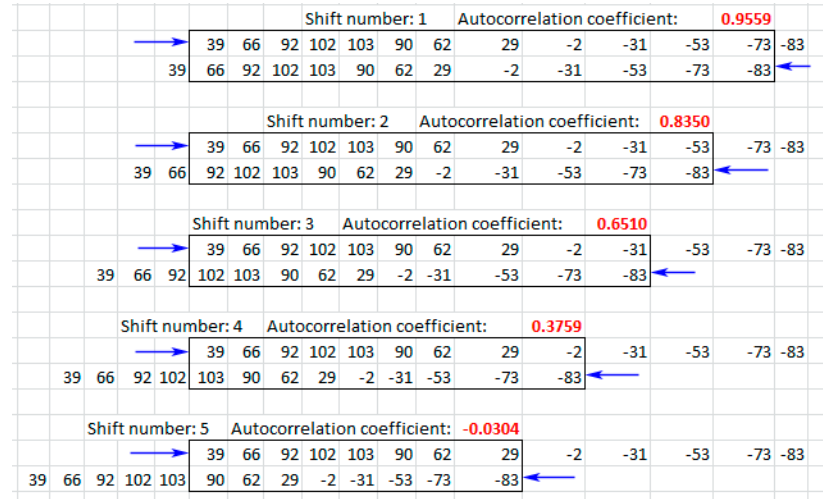
Figure 5. ( a )—1000 K window of acoustic data from arrow 2 (see Figure 1); ( b )—corresponding autocorrelation coefficients.